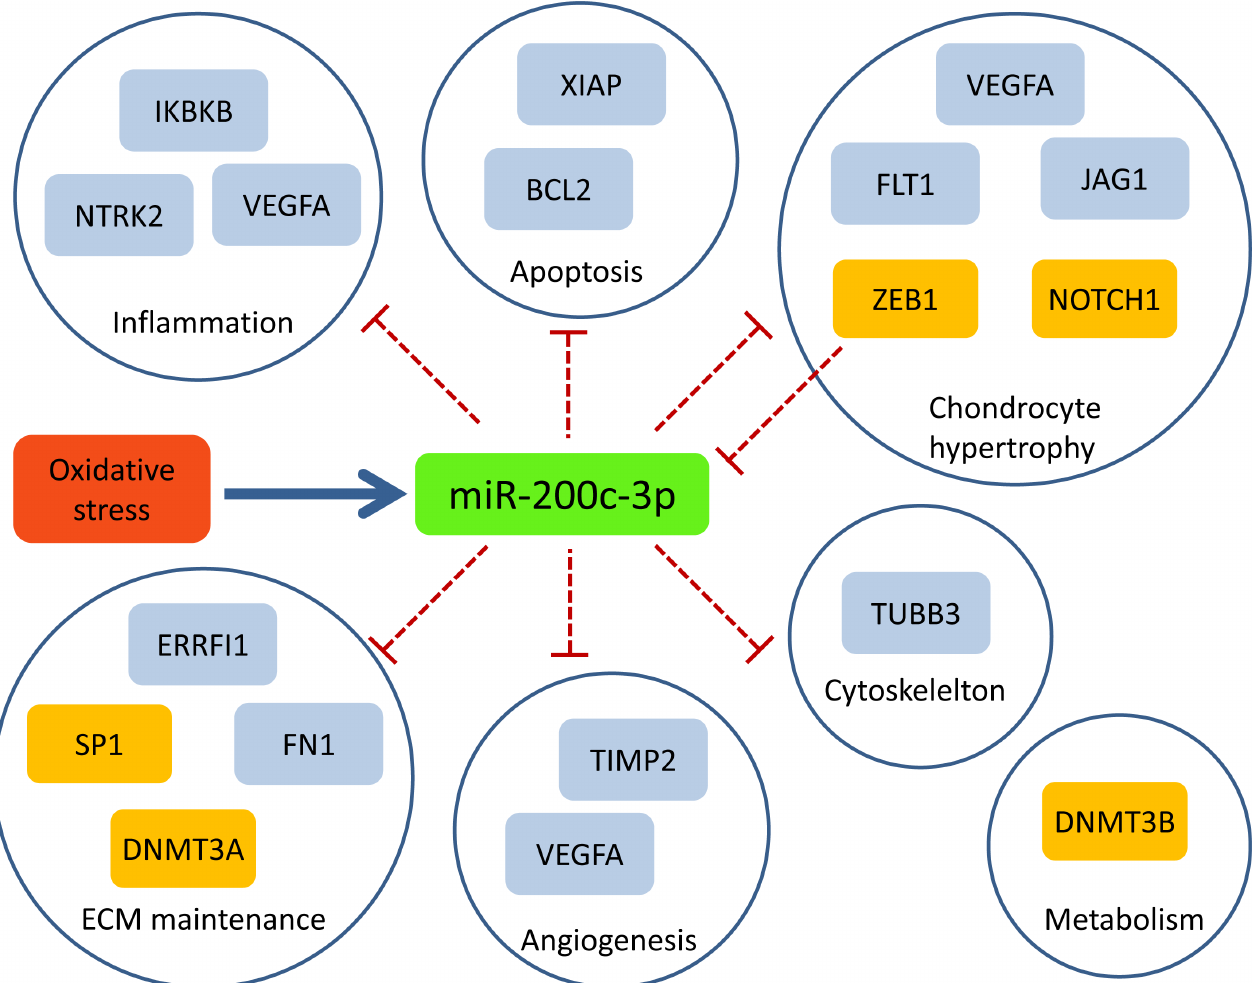
Fig 10. Potential role of miR-200c-3p in osteoarthritis. Oxidative stress leads to up-regulation of miR-200c-3p. Validatedtargets of miR-200c- 3p that are involvedin processes relevant to OA are shown. OA targets from targetvaliation.orgare shown in blue rectangles; targets in orange rectangleshave strong evidencein miRTarBaseand a literaturesearch reveals they are potentialtargets for OA. ZEB1 inhibits miR-200c-3p to provide a double-negative feedbackloop. Red dashed lines indicate inhibition.